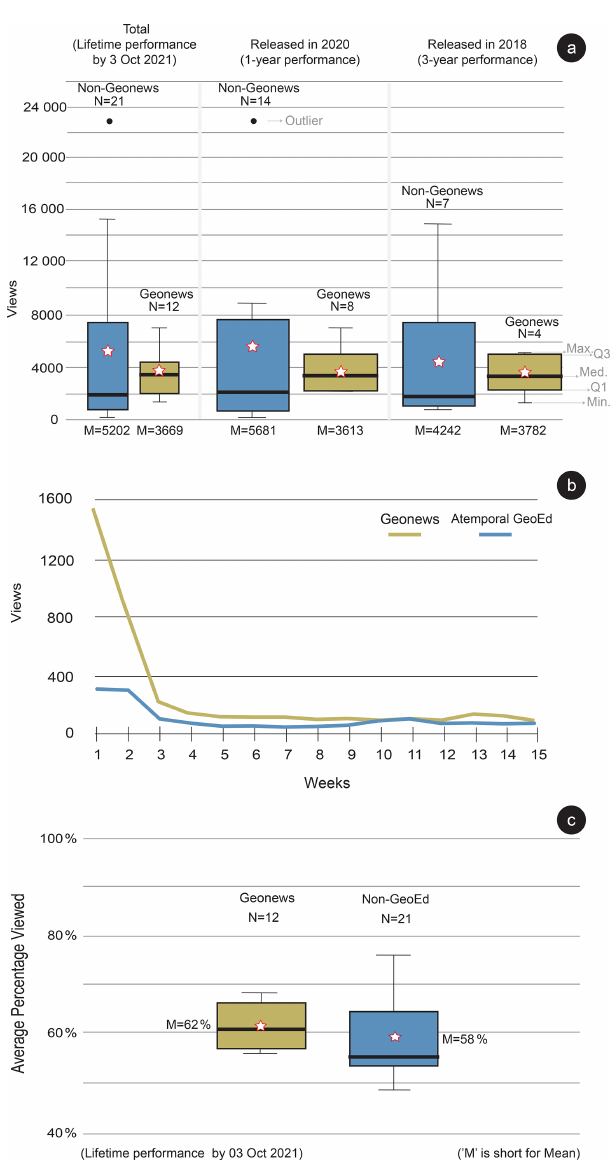
Figure 2. Comparison of views and average percentage viewed of Geonews and General GeoEd videos. (a) Views of Geonews and General GeoEd videos in lifetime: 1 year and 3 years. (b) Aver- age views of Geonews videos and General GeoEd videos over first 15 weeks following posting on YouTube. (c) Average view percent- age of Geonews videos and General GeoEd